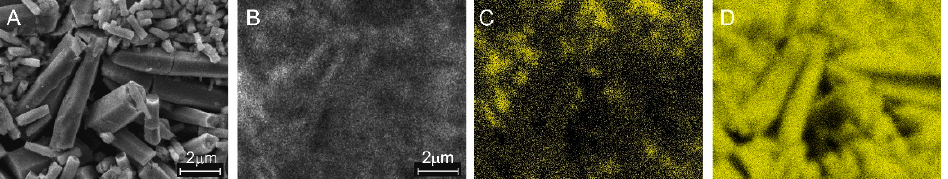
Figure 10. Secondary electron (SE) image ( A ), CL image ( B ), EDX signal for Mo ( C ) and EDX signal for zinc ( D ). for zinc ( D